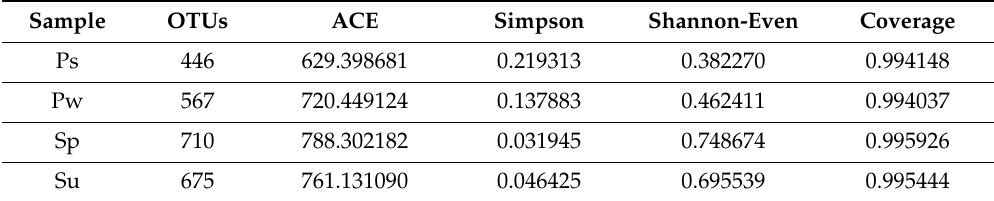
Table A3. Alpha diversity analysis at 5% dissimilarity based on the 16S rRNA gene Miseq sequencing